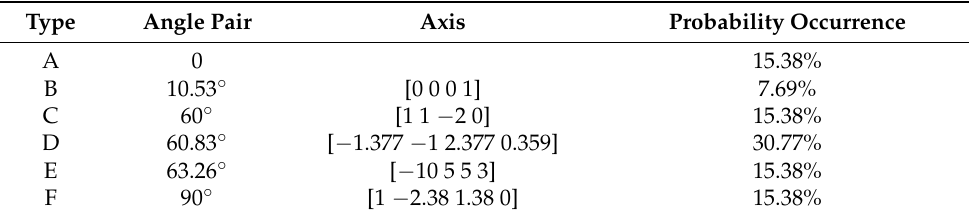
Figure 12. Misorientation angle distributions of TC4 alloy sheets: ( a ) and ( c ) hot-rolled; ( b ) and ( d ) 930 °C/15 min, WQ+560 °C/2 h, FC. Table 2. The six types of pair-wise misorientation between α and β phase.